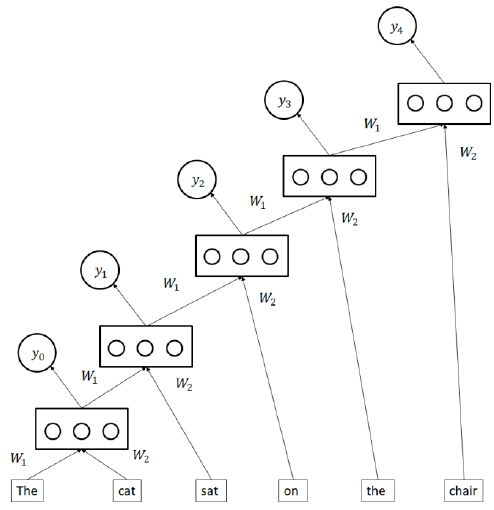
Figure 10. Recursive neural network.